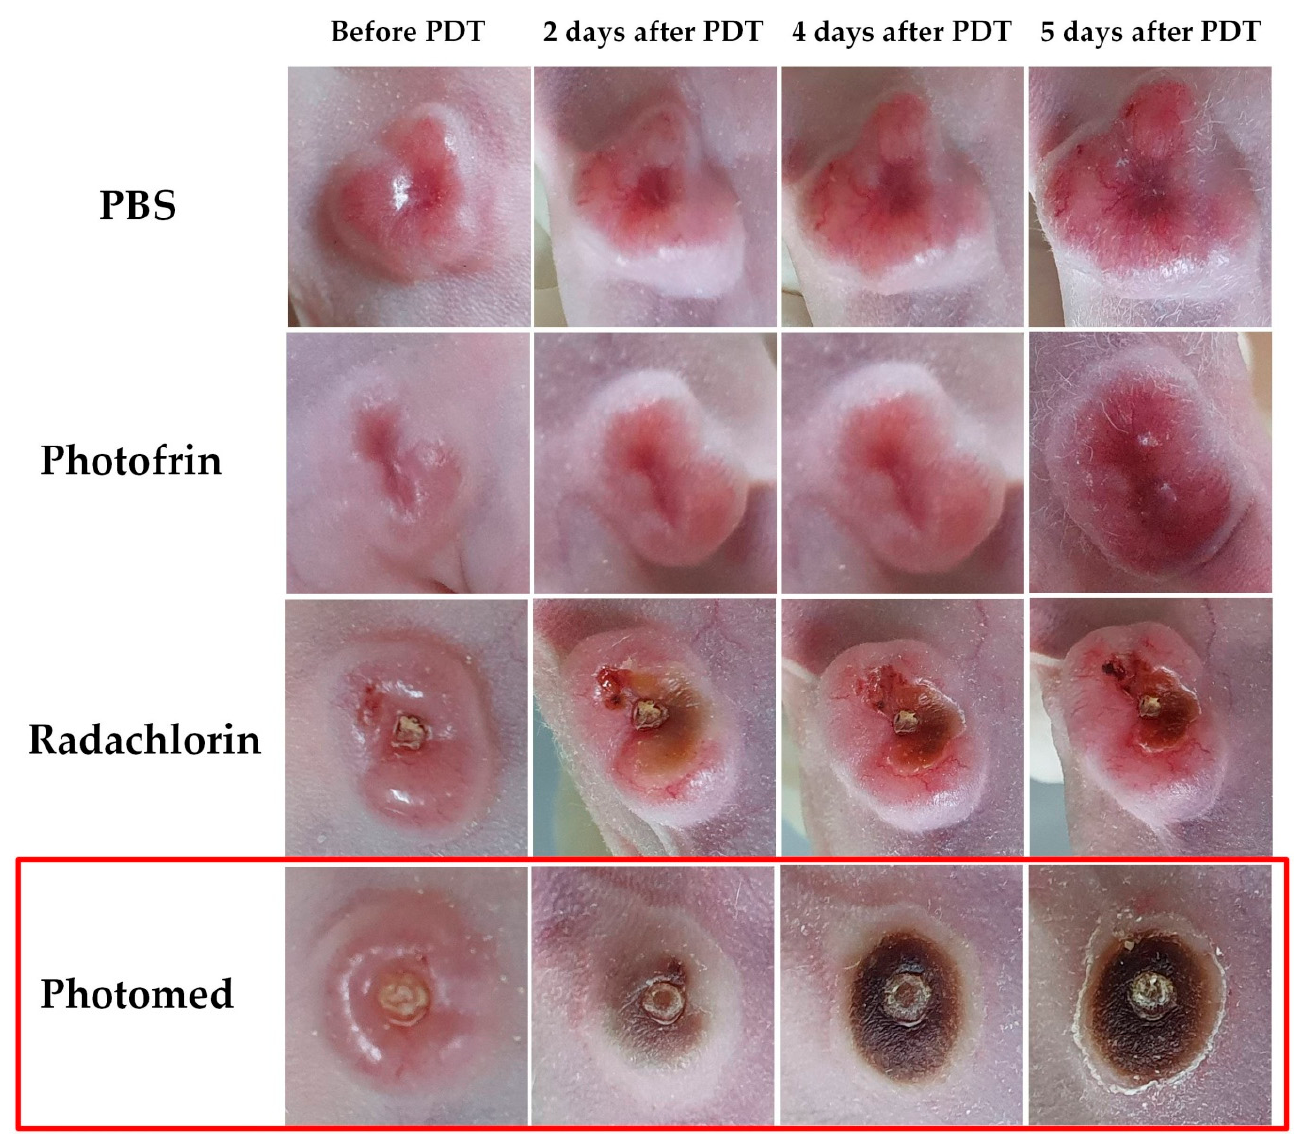
Figure 8. The representative tumor surface changes from SCC VII tumor-bearing mice before and after the first PDT with PBS, Photofrin, Radachlorin and Photomed. Table 1. Characteristics and preclinical data of Photofrin, Radachlorin and